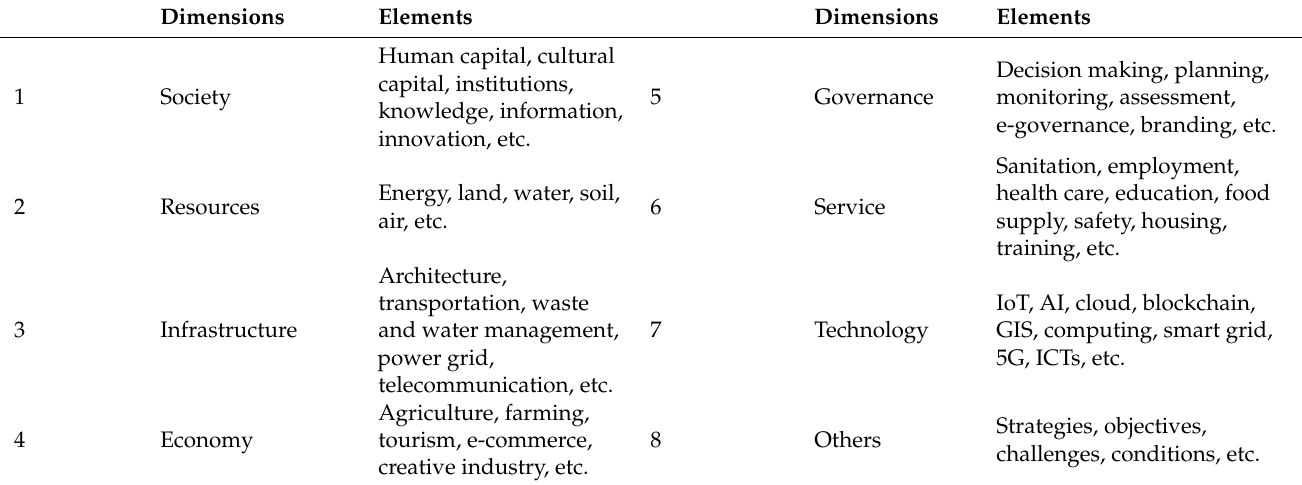
Table 3. Proposed conceptual classification system for smart village